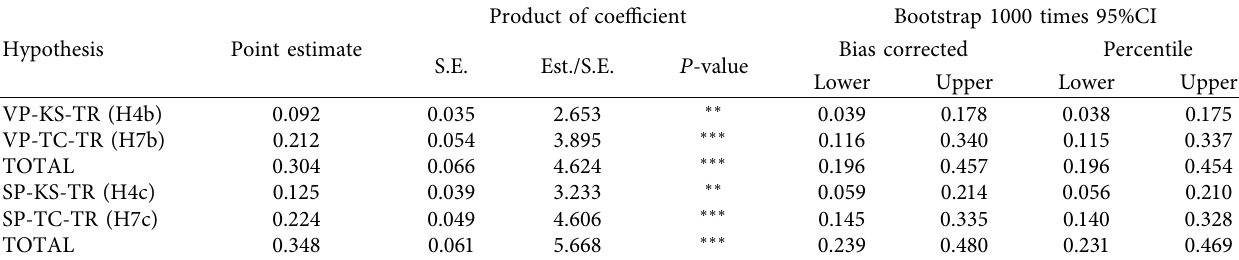
Table 6: Linear indirect effect test.